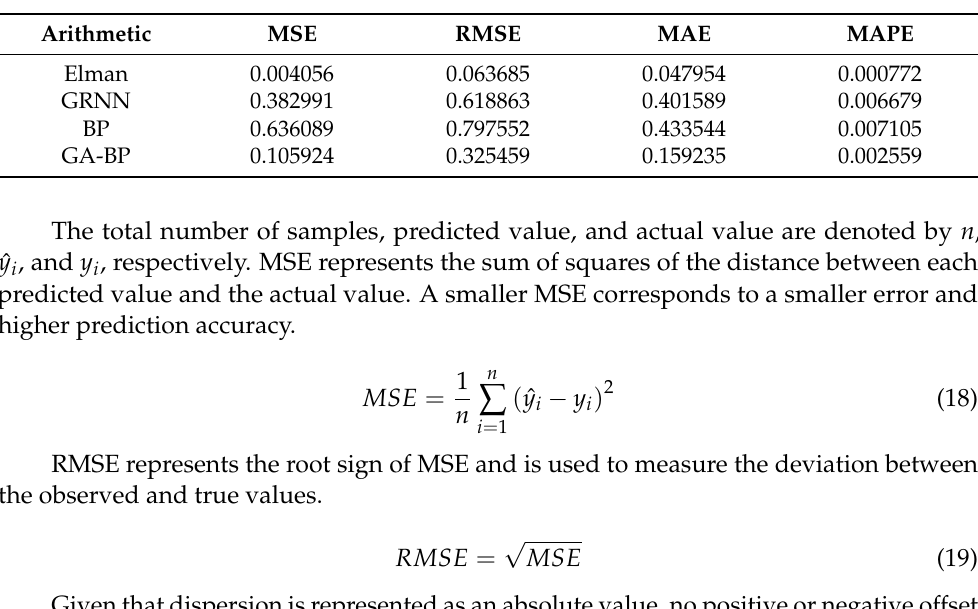
Table 4. Comparison of prediction errors of neural network algorithms.